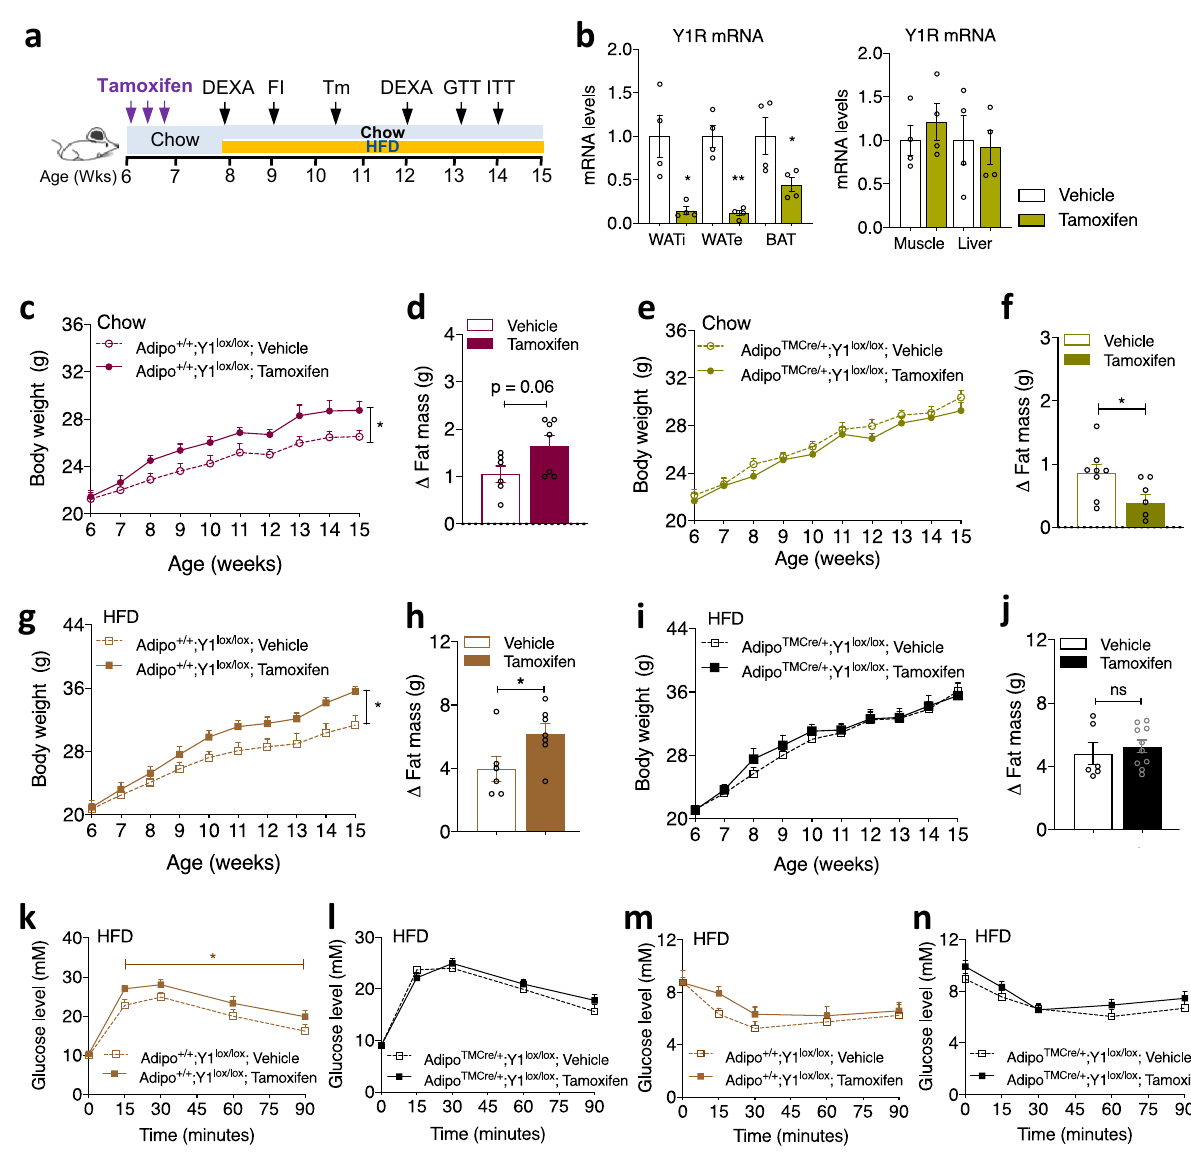
Fig. 8 Y1R signalling in adipose tissue is critical in obesity development. a Schematic illustration of the paradigm for phenotyping the tamoxifen-induced adipocyte-speci fi c Y1R deletion mouse model. b Relative Y1R mRNA expression in inguinal WATi, epididymal WATe, BAT, skeletal muscle and the liver